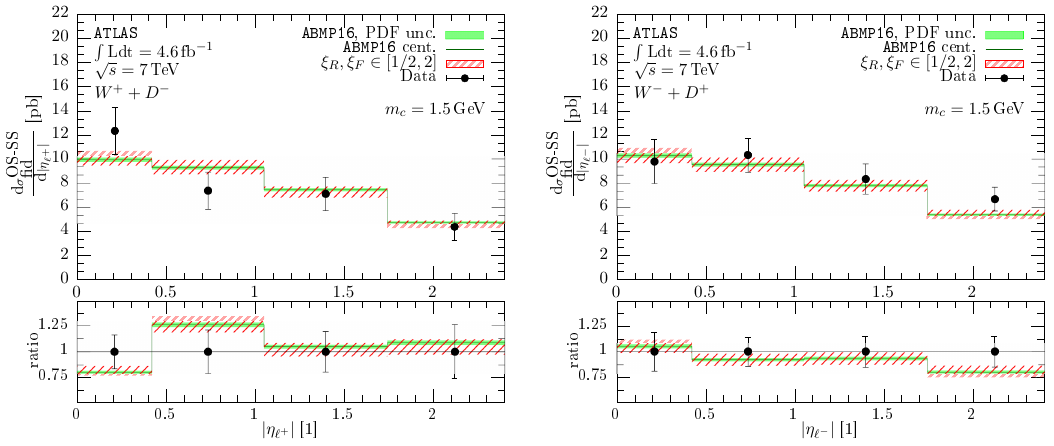
Figure 10 . Same as in figure 9, but using the PYTHIA8 Monash